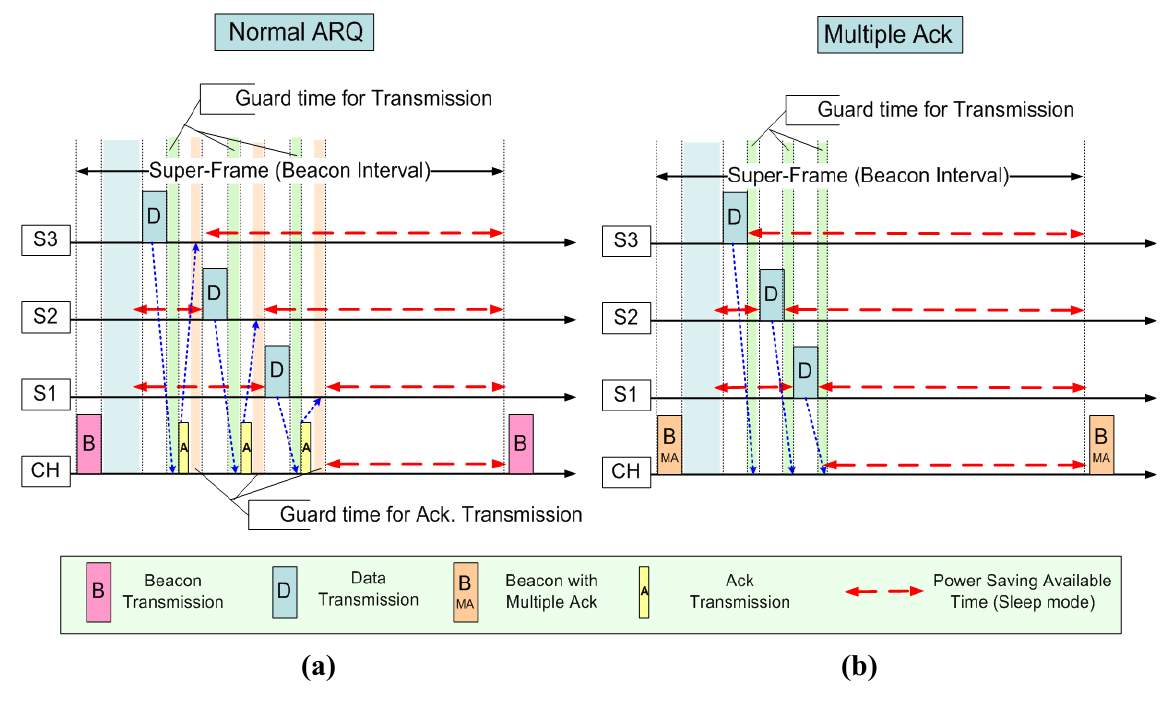
Figure 2. Multiple Access Examples for ARQ (a) and MA (b)